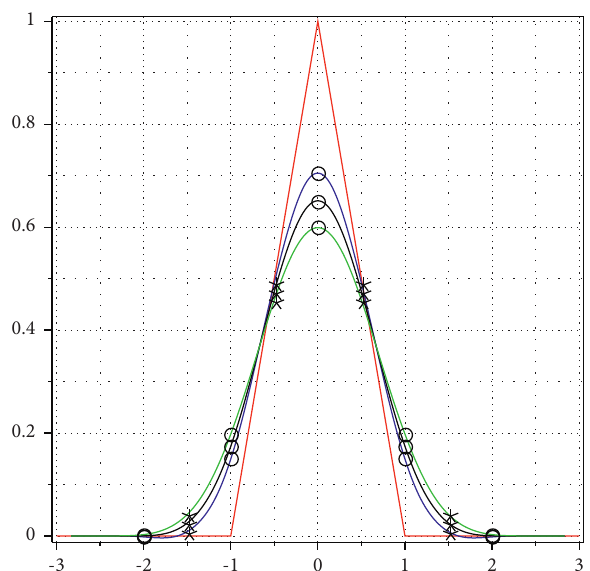
Figure 3: Basic limit functions produced by the 4-point scheme corresponding to (14) for different values of parameter w . The red lines denote the initial polyline, and the blue, black, and green lines represent the basic limit functions produced with w � − 1/256 , 0 , 1/256 respectively. The circles denote the evaluations of the basic limit function at integers, and the asterisks denote the evaluations of the basic limit function at half